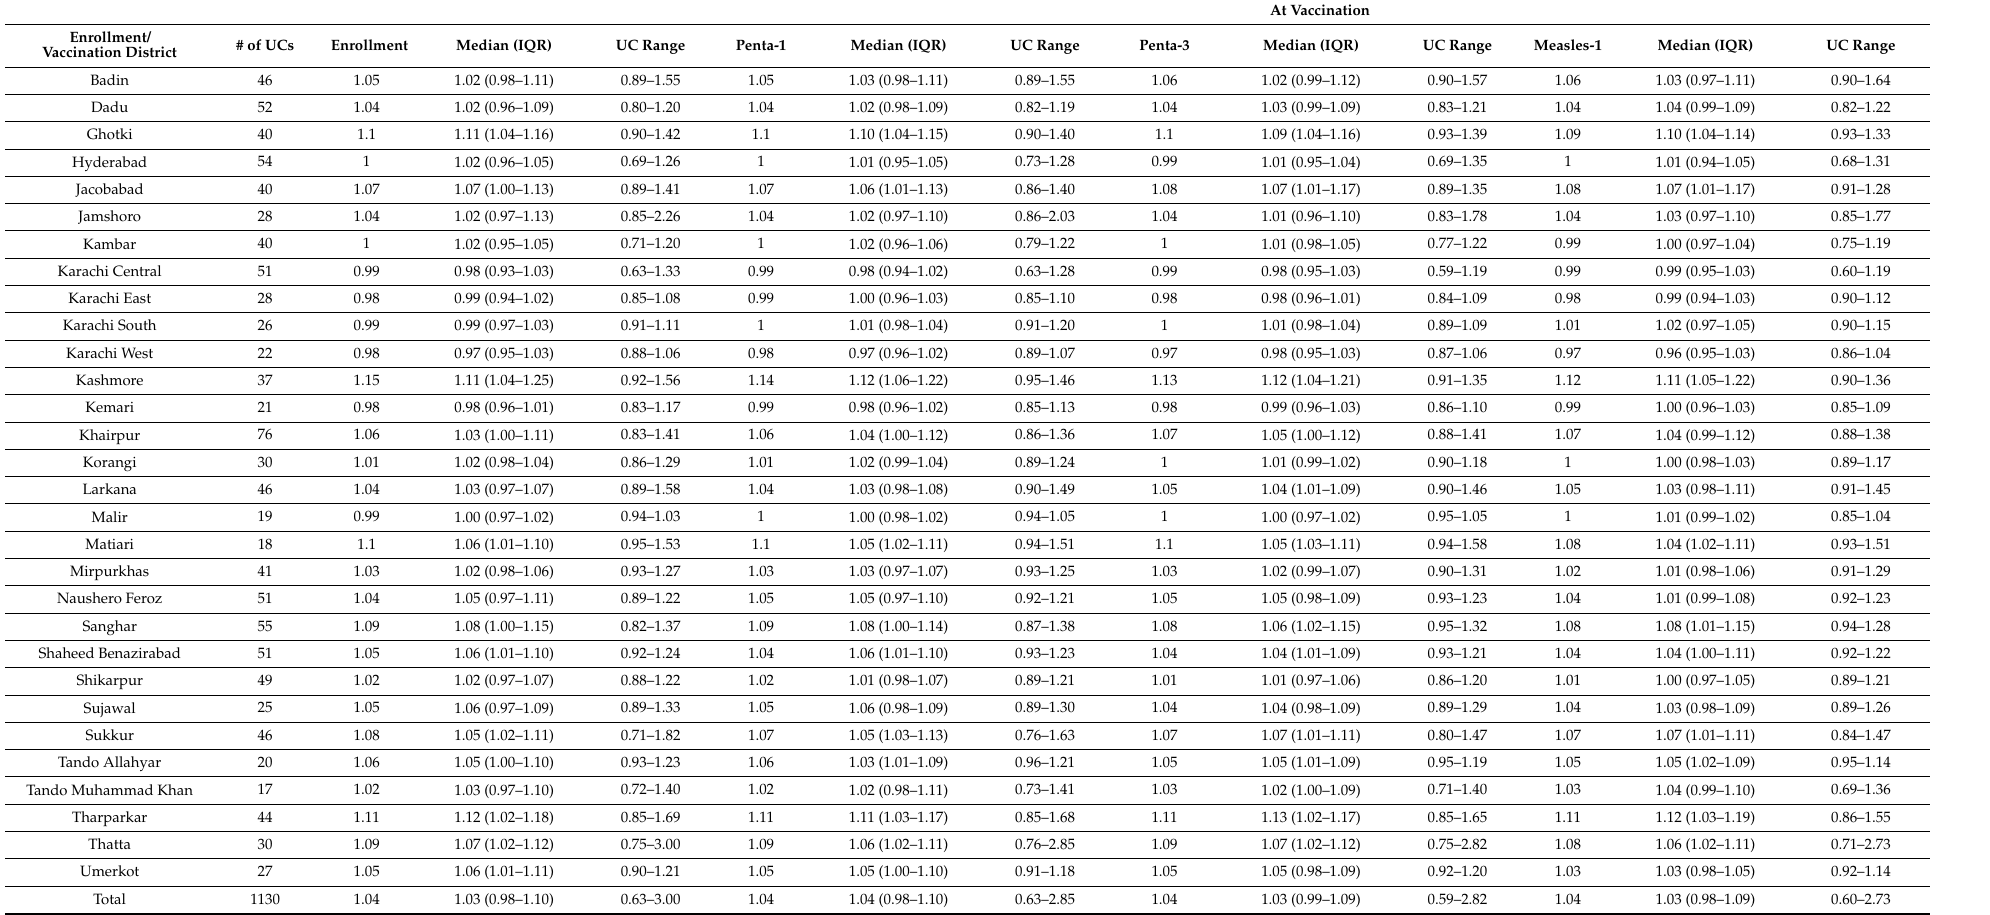
Table 1. District-wise adjusted male-to-female ratios of 0–23-month-old children in 2019–2022 birth cohorts enrolled in SEIR and vaccinated, by district ( n =